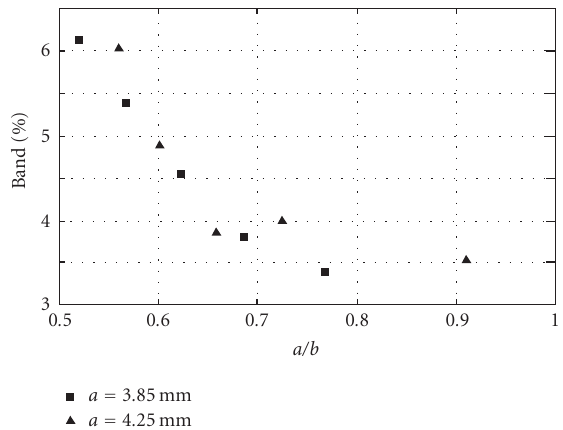
Figure 8: Radiation patterns for a DRA with a = 4 . 25 mm, and a/b = min( a/b ) = 0 . 55 or a/b = max( a/b ) = 0 . 91: (a) xy plane ( E -plane); (b) yz plane ( H